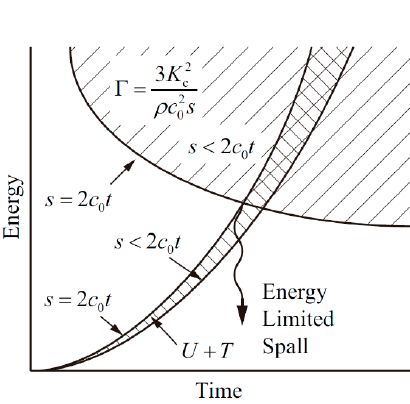
Figure 8. Schematic diagram of Grady brittle spallation model.